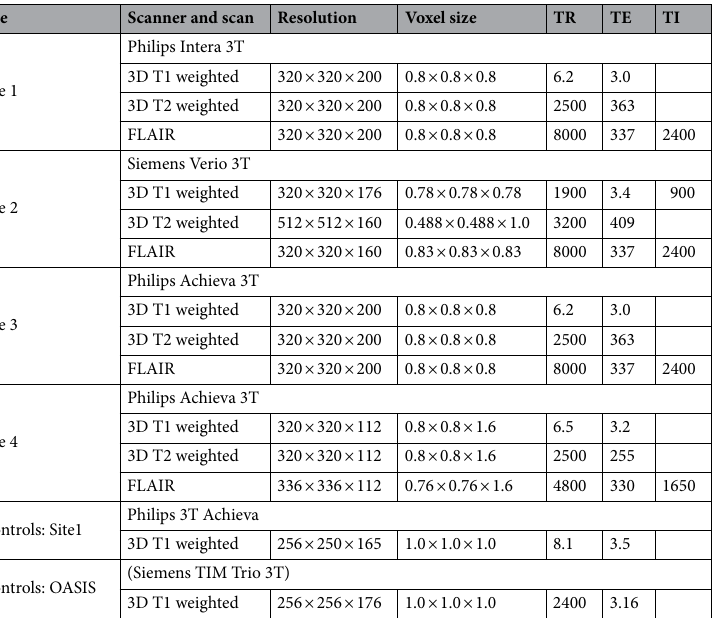
Table 1. MRI acquisition parameters. 3 T = 3 Tesla; 3D = 3-dimensional, TR = repetition time; TE = echo time; TI = inversion time; FLAIR = Fluid Attenuated Inversion Recovery; Site 1 control scans were acquired with parallel imaging, SENSE factor